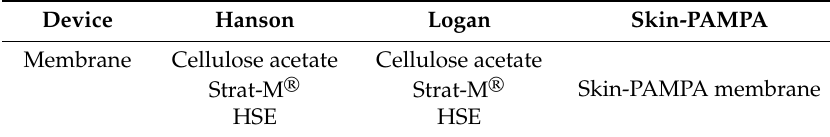
Table 2. The experimental design of drug di ff usion and penetration